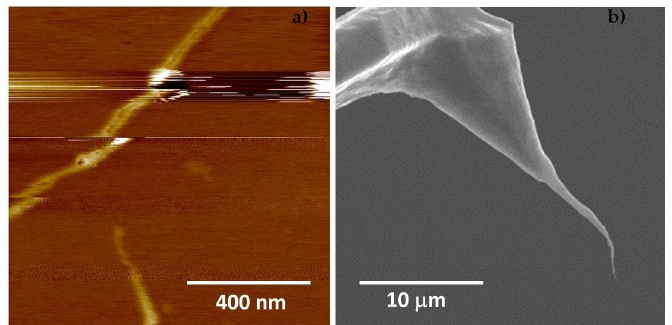
Figure 1. ( a ) An atomic force microscopy(AFM) image of carbon nanotubes on silicon obtained in tapping mode with a long carbon nanotube (CNT) (~10 µ m) attached to a tapping mode probe. ( b ) shows the corresponding scanning electron microscope (SEM) image for the probe used to acquire the AFM image in Figure 1a. The instability in the AFM image is clear. The height or color scale of the AFM image is 20